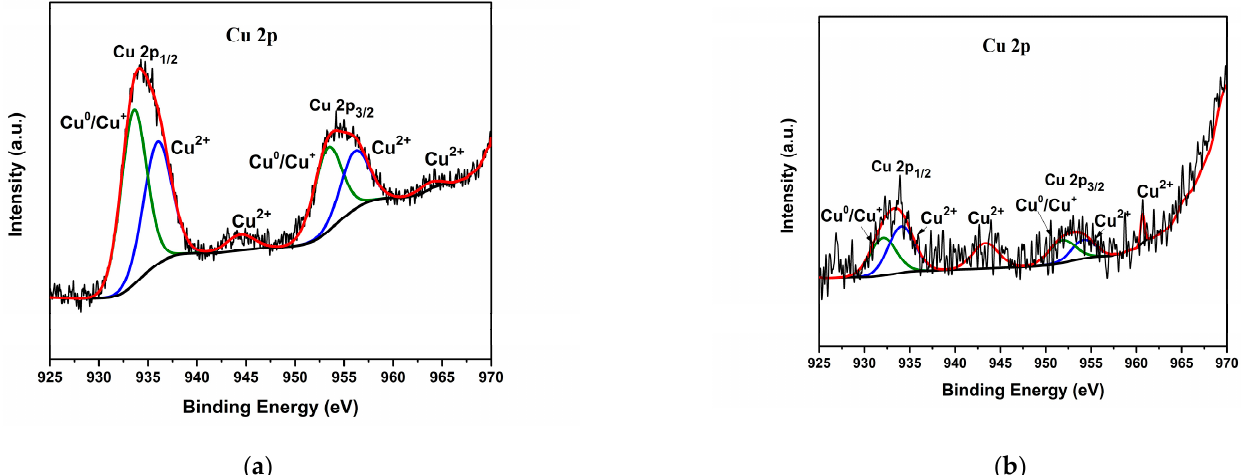
Figure 4. High-resolution XPS spectra of Cu 2p for ( a ) Cu/Cu x O-PCC-1h and ( b ) Cu/Cu x O-PCC-6h.